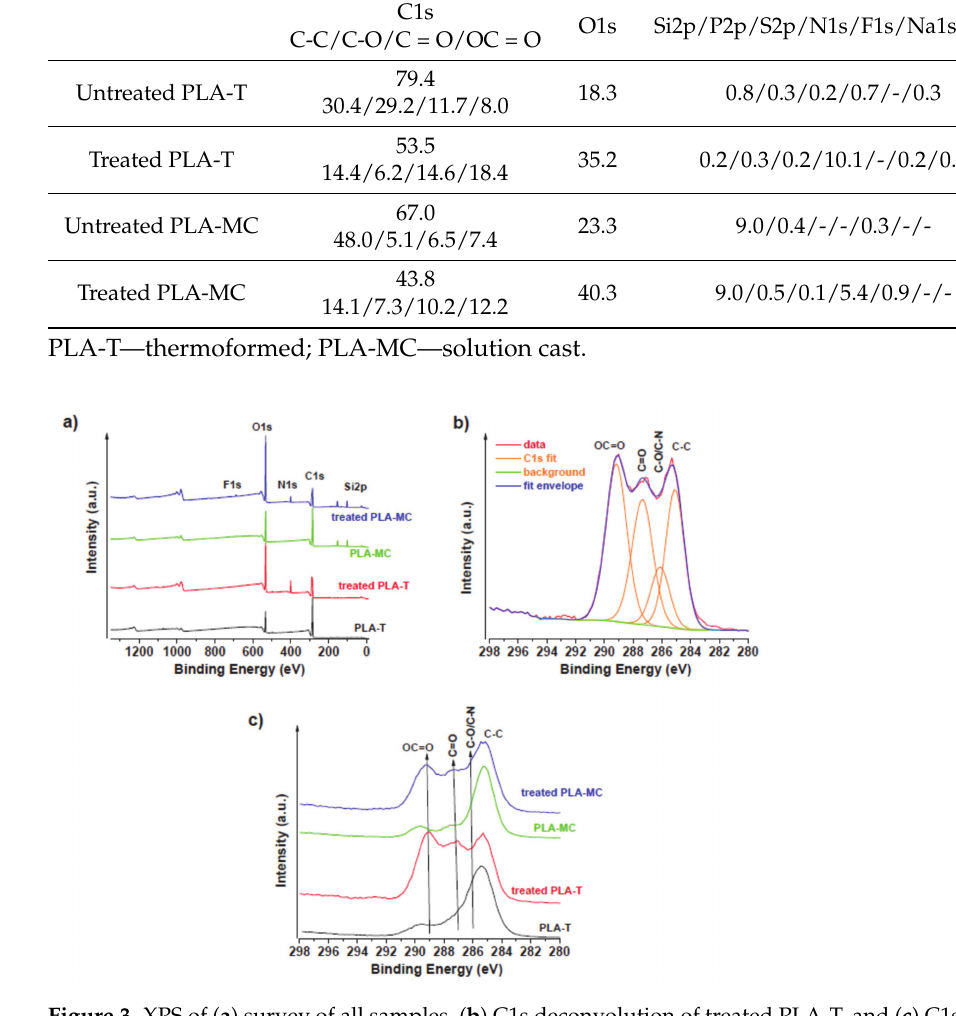
Figure 3. XPS of ( a ) survey of all samples, ( b ) C1s deconvolution of treated PLA-T, and ( c ) C1s region of all